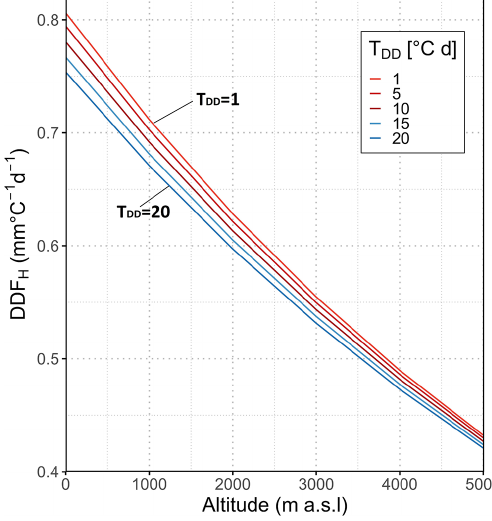
Figure 7. Variation of sensible heat component (DDF H ) at different altitude based on different degree days, RH = 0%, and u = 1ms − 1